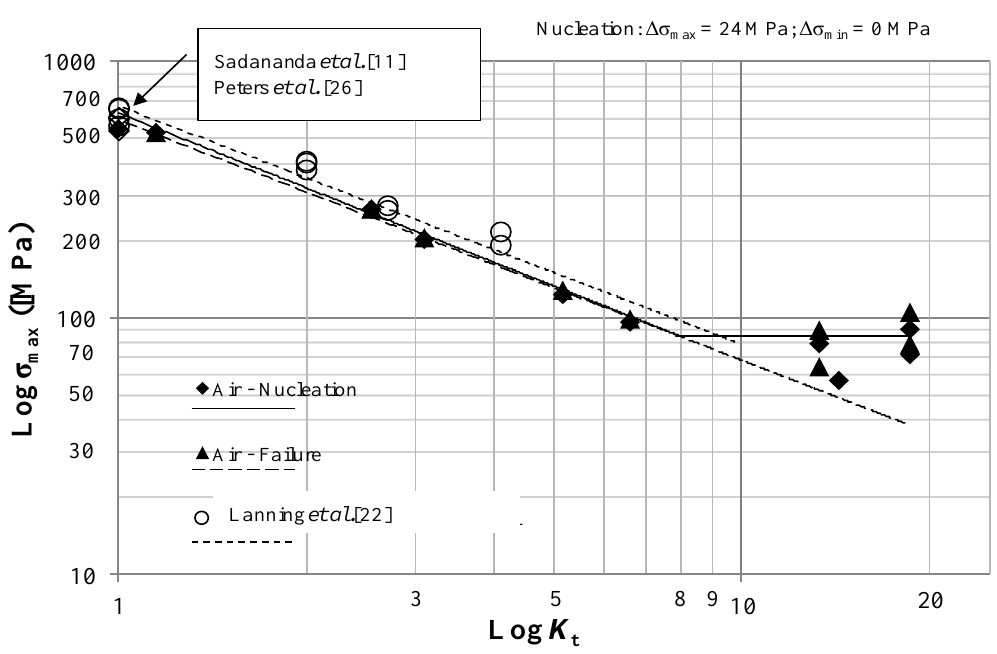
Figure 11. Log-limiting maximum stress ( R = 0.1, 10 Hz ) at initiation and failure vs. Log- K constant life of 200,000 cycles for the samples tested in air.